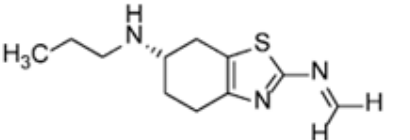
Figure 6. Synthesis of ( S )- N 2 -(methoxymethyl)- N 6 -propyl-4,5,6,7-tetrahydro-1,3-benzothiazole-2,6- diamine.